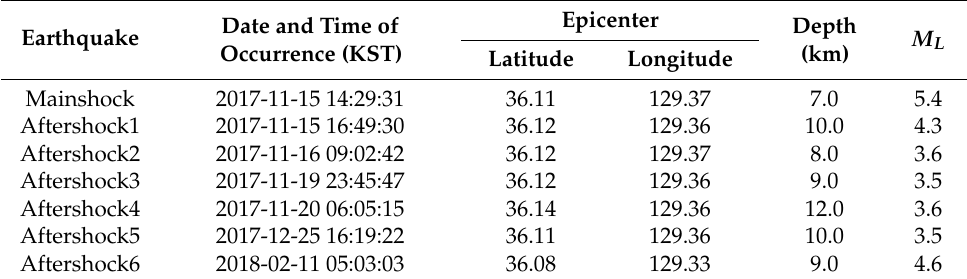
Figure 1. Epicenters of major events of the 2017 Pohang earthquake [1]. Table 1. Major events of the 2017 Pohang earthquake [1].